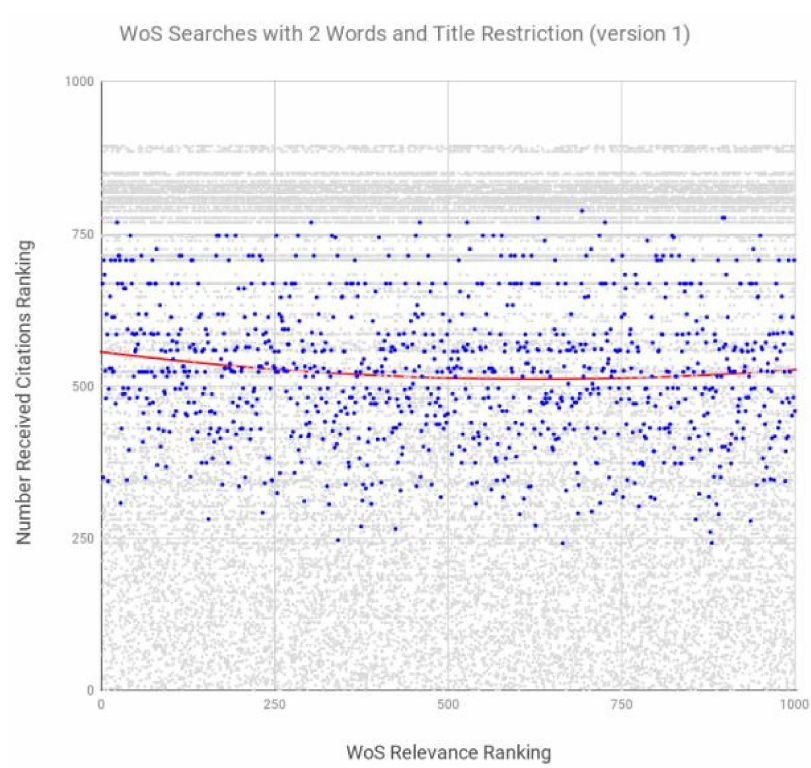
Figure 9. WoS Searches with Two Words and Title Restriction (Version 1) (rho − 0.075, median in blue, the rest of data in